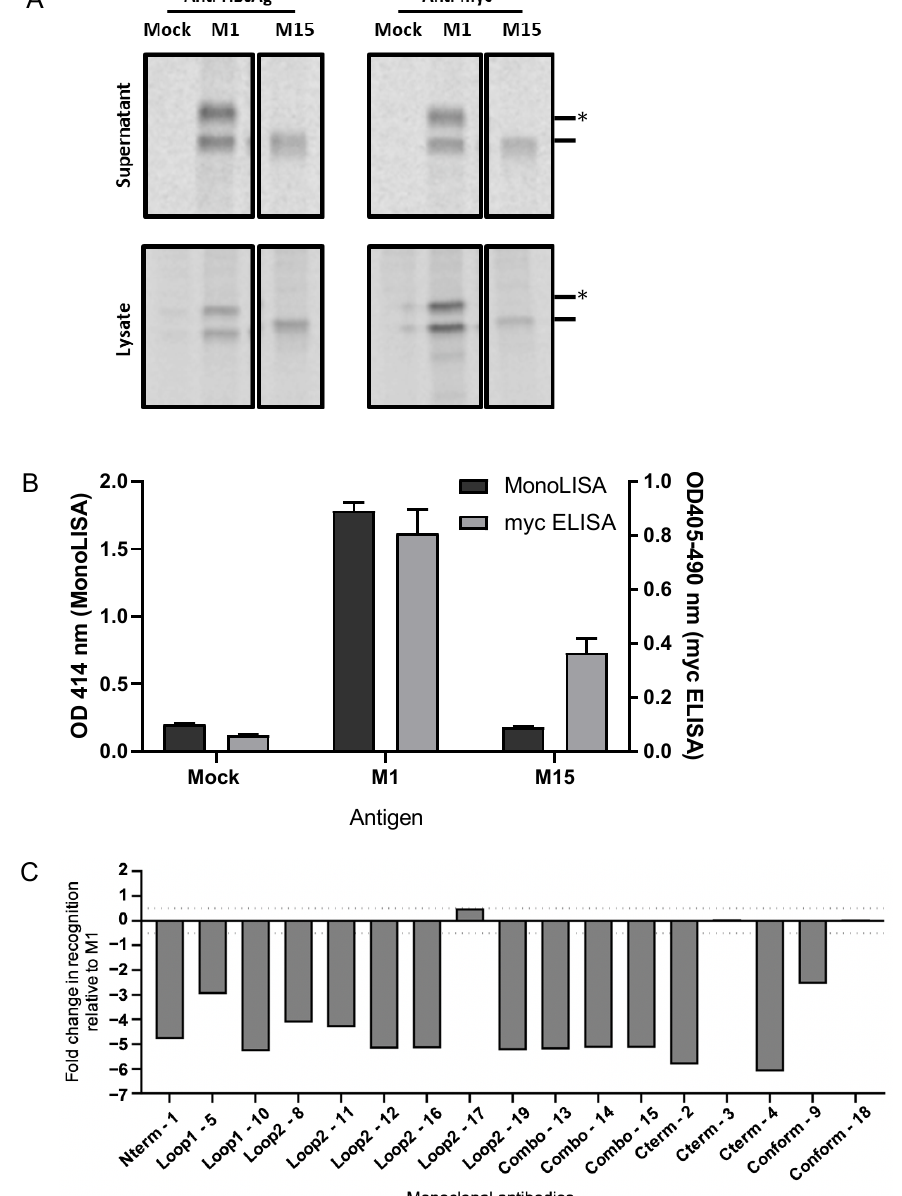
Figure 1. Expression and secretion of myc-tagged M1- and M15-HBsAgS proteins produced in HEK293T cells. Cells were transfected with plasmids expressing M1- or M15-HBsAgS. As a control, cells were mock-transfected. Detection of 35 S-labelled HBsAgS protein in the cell culture medium and cell lysate by immunoprecipitation with ( A ) polyclonal anti-HBsAg and anti-myc monoclonal antibodies. Protein (dash) and glycoproteins (asterisk) are indicated. ( B ) Anti-HBsAg (MonoLISA, Bio-Rad) and anti-myc ELISA using cell culture medium, n = 3, in duplicate, graphed mean and standard error of the mean (SEM). ( C ) The HBsAg-specific antigenicity of M15-HBsAgS was assessed relative to M1-HBsAgS using the Bio-Plex Assay. Antibodies directed against the N-terminal re- gion, loop 1, loop 2, combination of both loops (Combo), C-terminal region, and conformational epitopes (Conform) were used to assess antigenic changes across the length of the modified HBsAg proteins. Antigenic reactivity between 0.5 and − 0.5 is considered the normal variation of this assay; values greater or less than this are considered significant antigenic changes; values less than − 3 are considered complete epitope